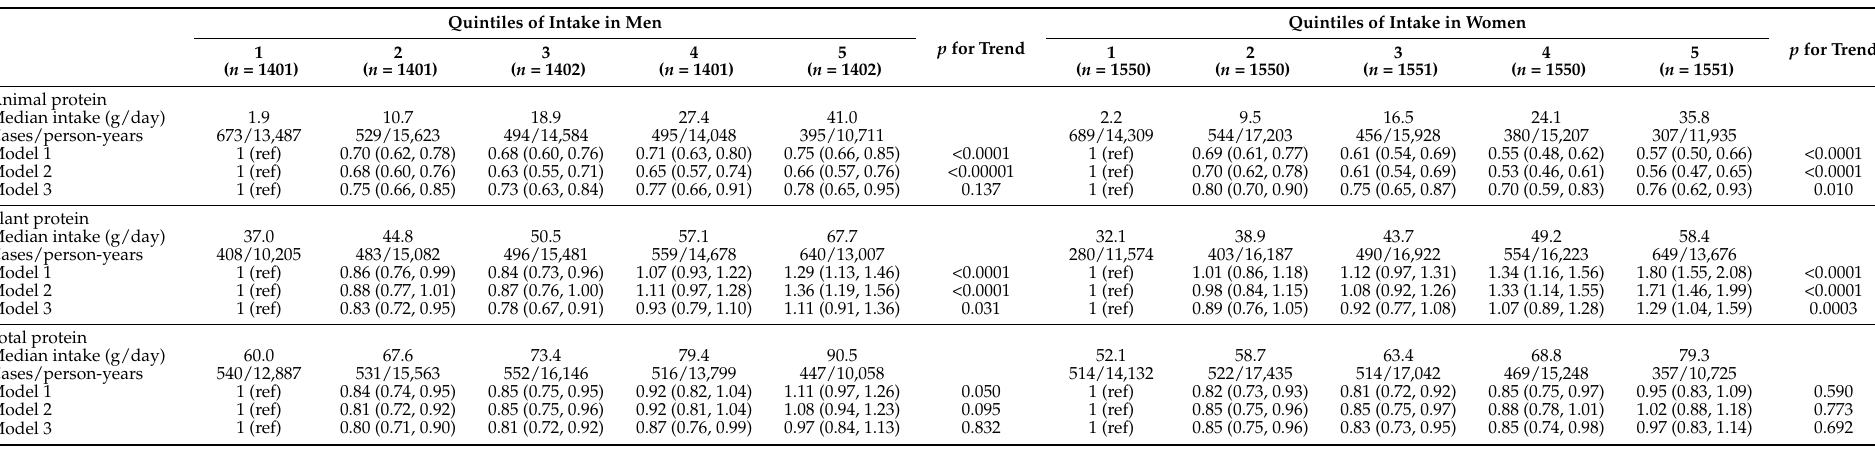
Table 3. Associations between hypertension risk and cumulative average dietary intakes of animal, plant, and total protein in Chinese men and women 1 .